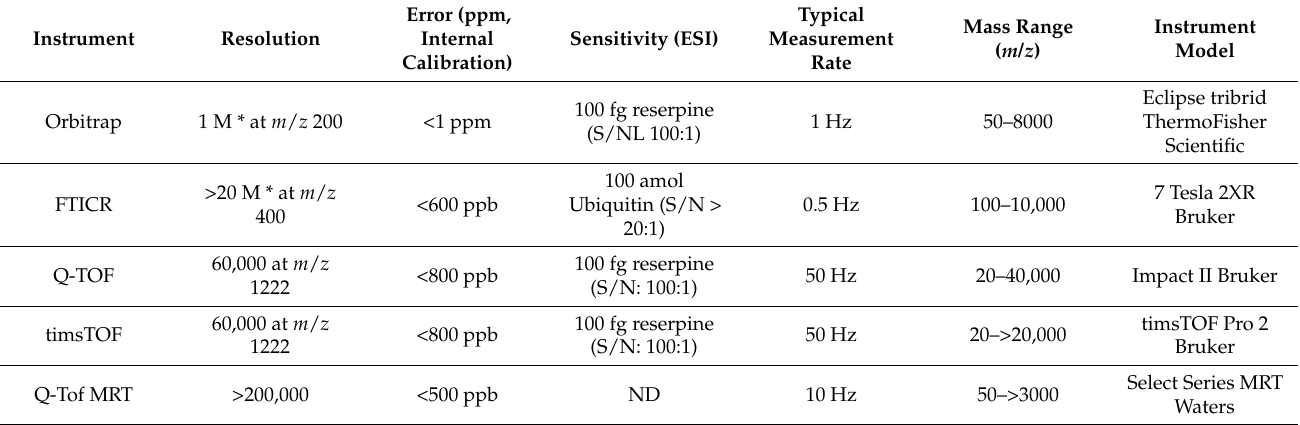
Table 2. Performances of several HRMS instruments (manufacturer’s specification sheet). An asterisk (*) indicates maximum resolving power (the resolution decreases as the acquisition measurement rate increases). (ND: No